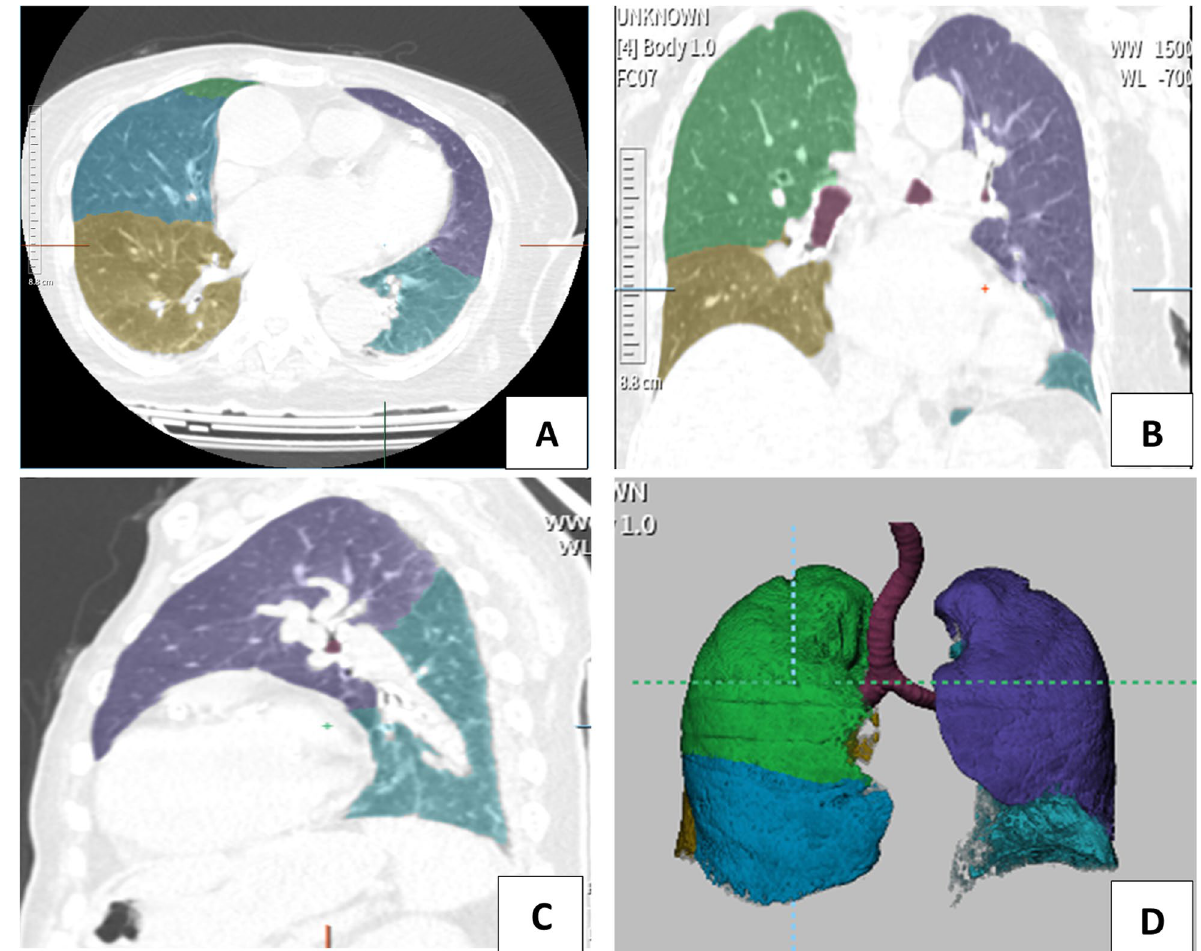
Fig. 1 Automatic lung segmentation in 2D axial ( A ), coronal ( B ) and sagittal planes ( C ) with 3D reconstruction ( D